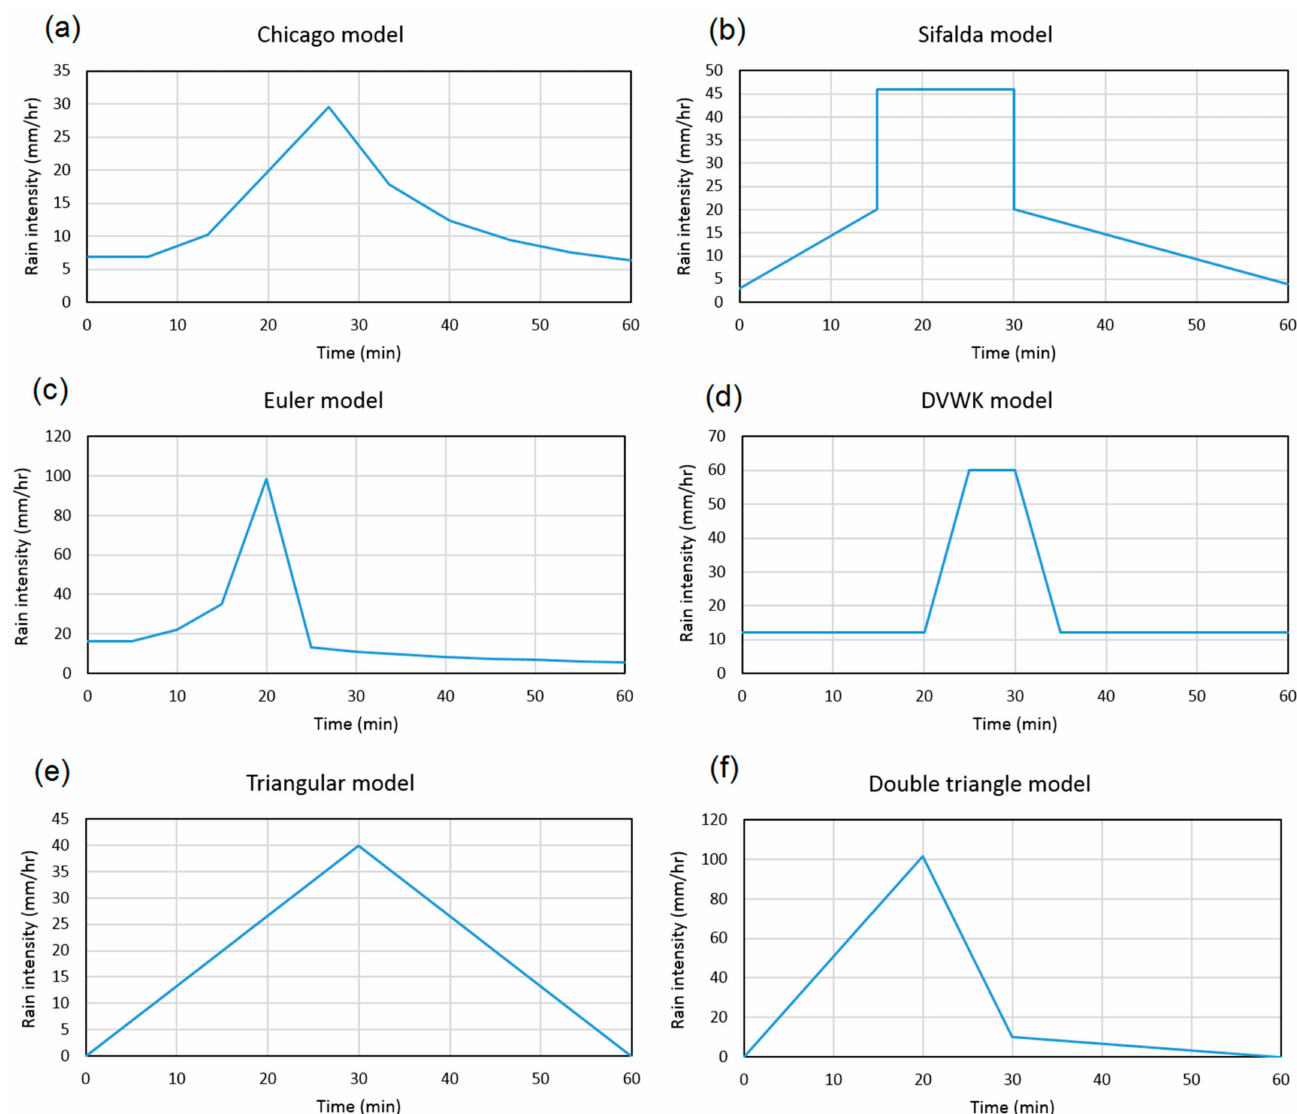
Figure 2. Exemplary model rainfall hyetographs for H = 20 mm and t = 1